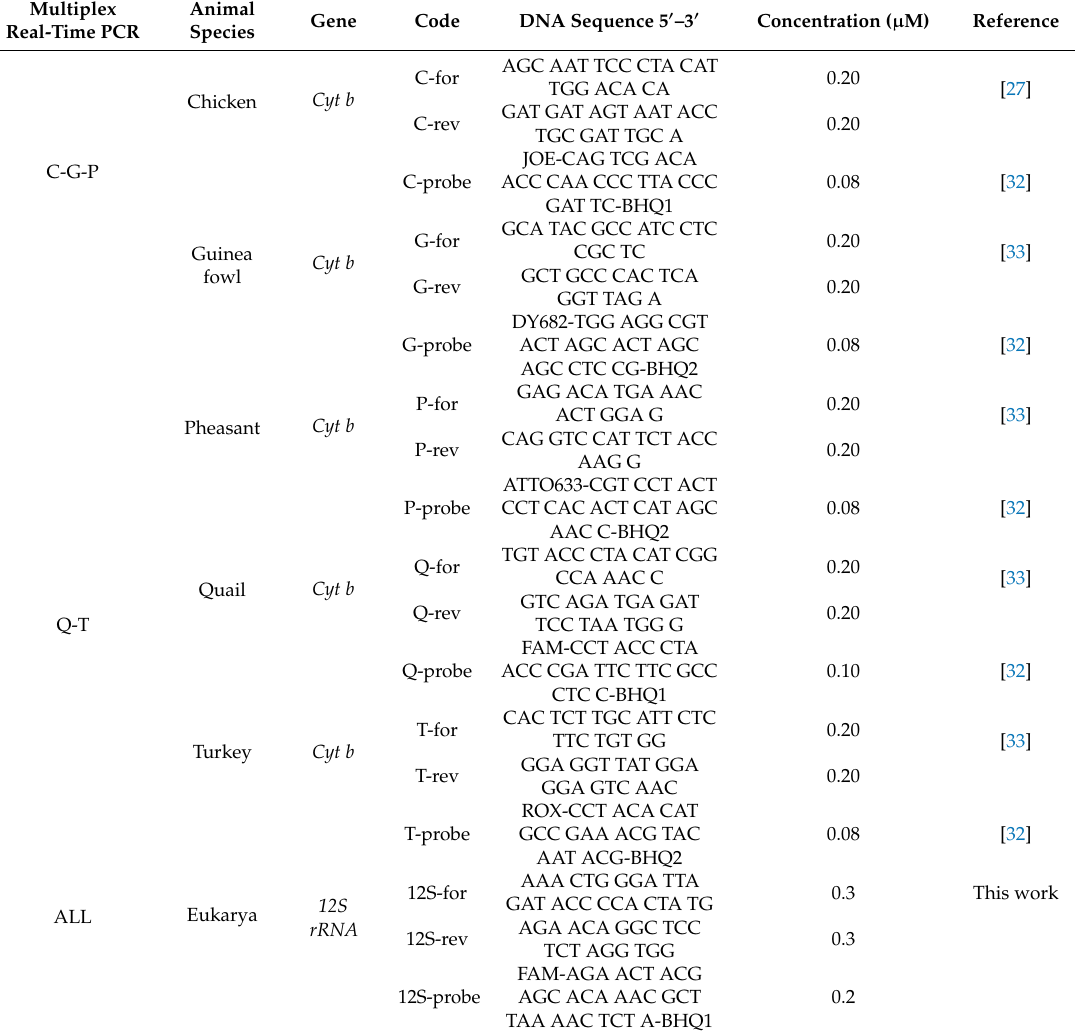
Table 2. Sequences of primers and